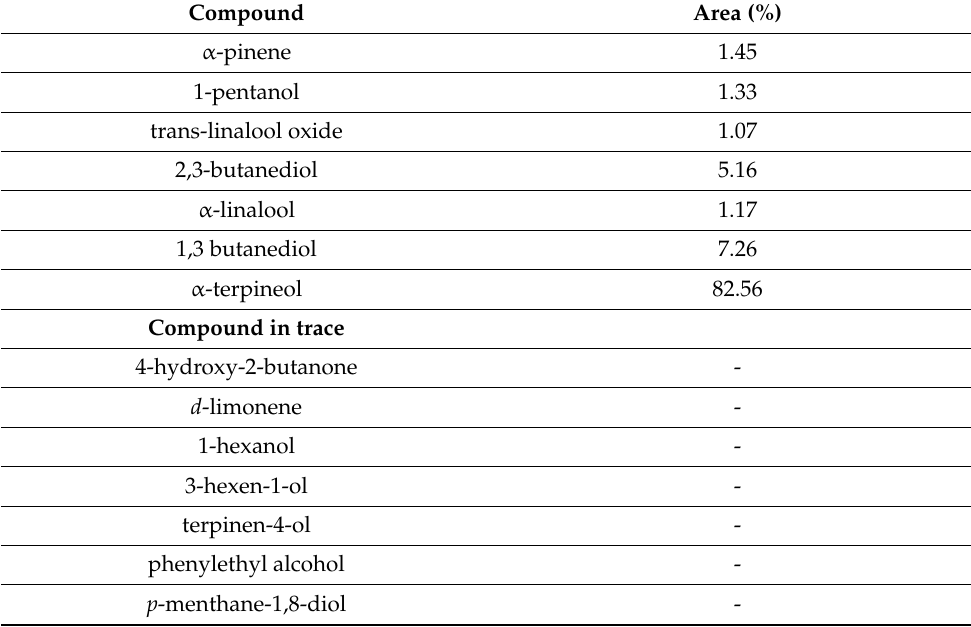
Table 5. Volatile compounds in bitter orange IntegroPectin.